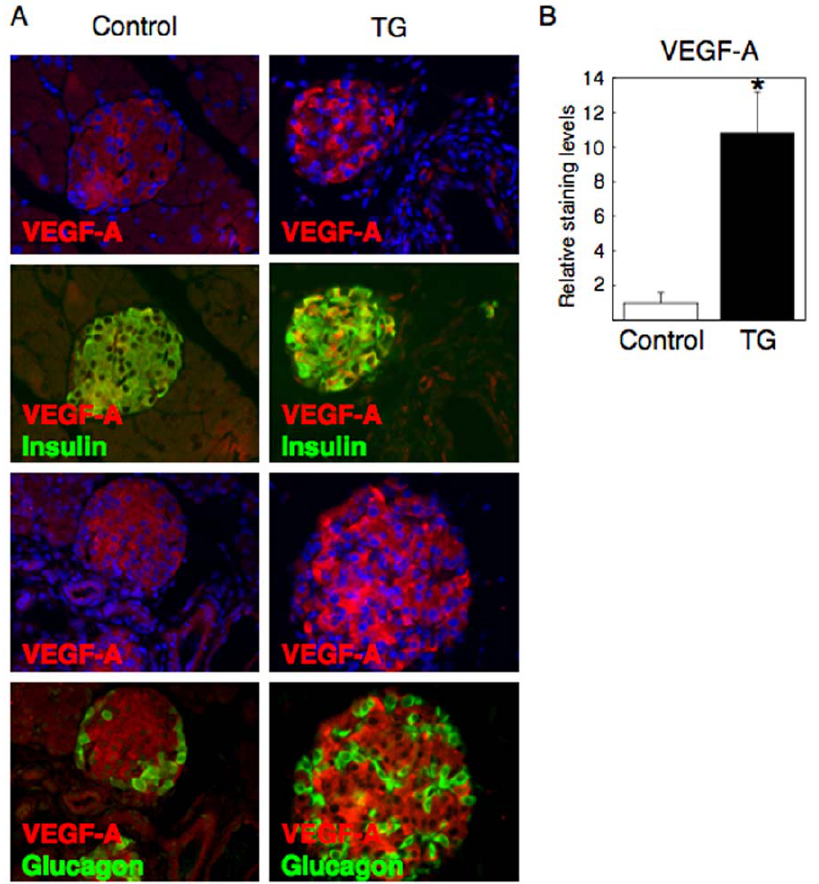
Figure 5. Enhanced VEGF-A expression in b cells but not a cells in TG mice. ( A ) Double immunostaining of VEGF-A with insulin or glucagon in pancreatic sections from TG mice and control mice. Enhanced VEGF-A staining (red) in TG mice is completely merged with insulin staining (green to yellow) but not with glucagon staining (green). (B) Quantitative analysis of VEGF-A staining levels in the islets of TG and control mice. We measured the staining levels of VEGF-A per unit area by using NIS-Elements (Nikon) and Image-J (NIH). Six mice were analyzed for each genotype and representative images are shown.